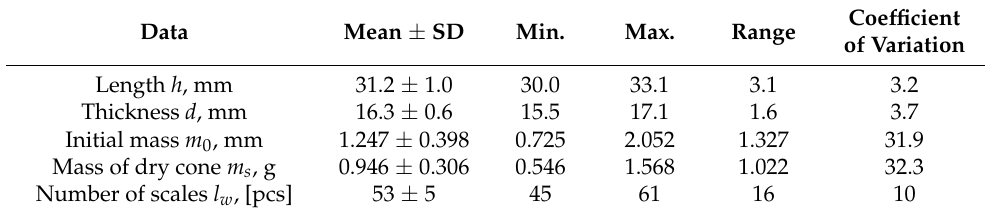
Table 1. Characteristic parameters of the studied